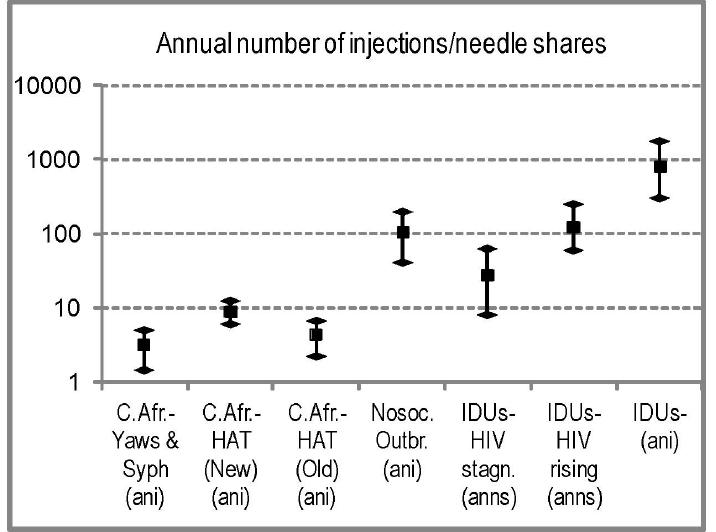
Figure 4. Comparison of injection intensities in the Central African campaigns (first three categories) and relevant modern populations (remaining categories). (ani): annual number of injections; (anns): annual number of needle shares. The seven categories, from left to right, are as follows: ( i ) to ( iii ) Central African data, based on our review (Tables 1 and 2); ( iv ) available estimates for nosocomial outbreaks (sources: [123,124]); ( v ) estimates of needle sharing for IDU groups in which HIV-1 prevalence was either <5% or stagnant since many years previous to observation (sources: [129,130,135,138–140]); ( vi ) estimates of needle sharing for IDU groups in which HIV-1 prevalence was >10%, had risen fast in previous years, and the study could observe needle sharing rate at the onset of a needle exchanging program, methadone, or other intervention (known to cause dramatic drops in needle sharing) (sources: [125,128,131–133,136,137]); ( vii ) estimates of annual number of injections (with or without sharing) for IDUs (sources: [125–131,140]). For each category, the range and average between studies are